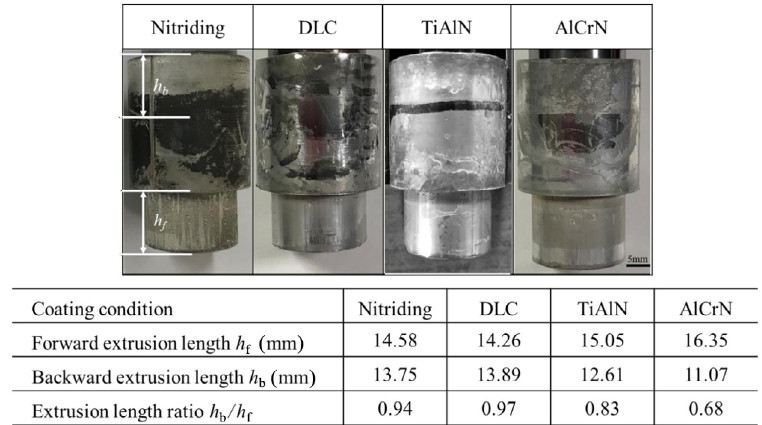
Fig. 8 Hot forward–backward extrusion test in each coating (billet temperature: 500 °C; punch speed: 0.5 mm/s).